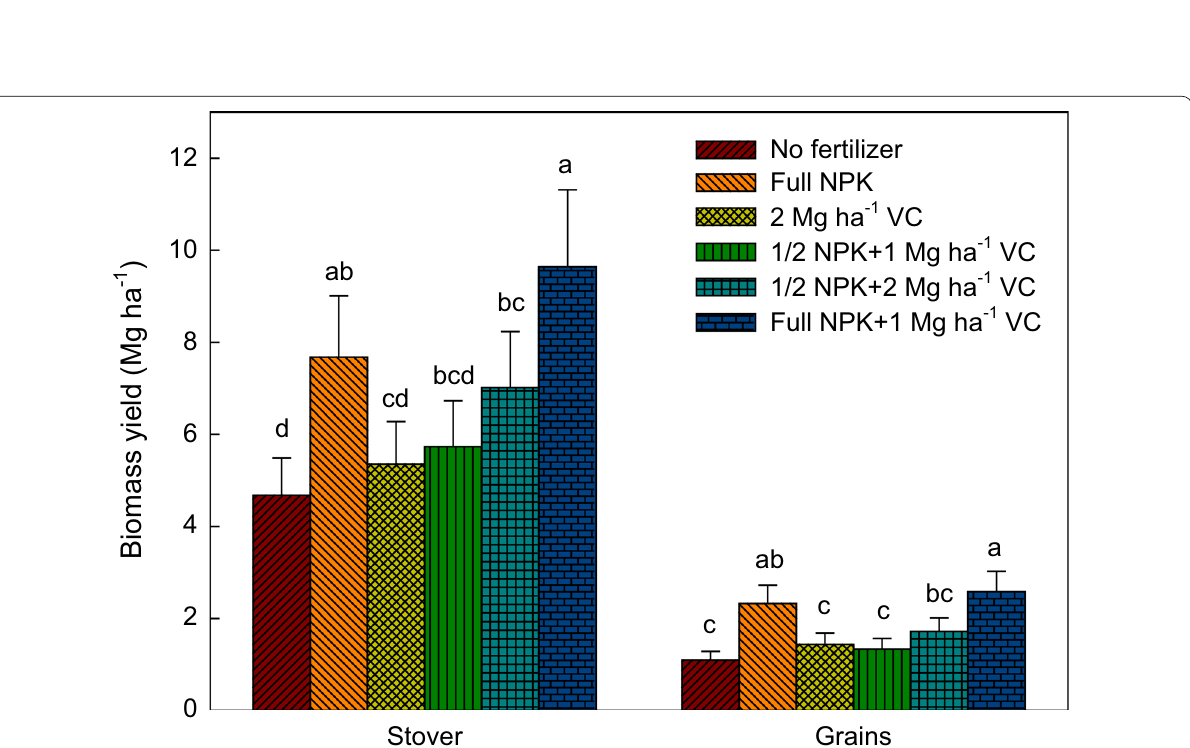
Fig. 3 Stover and grain biomass yield of sweet corn as influenced by different fertilization. Vertical bars indicate standard deviations ( n